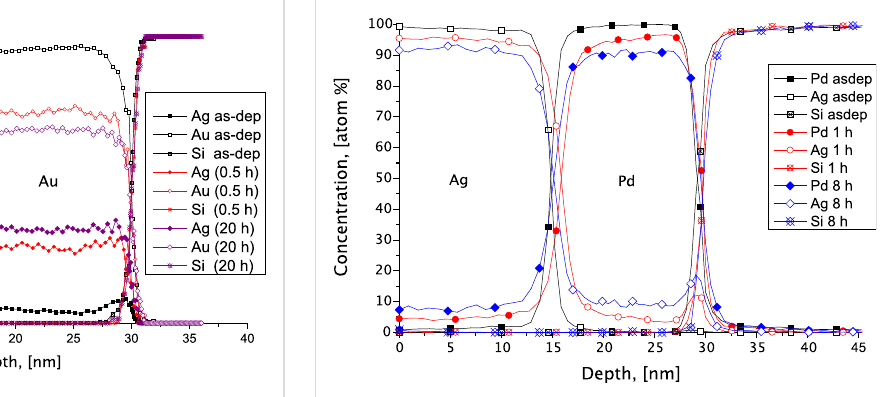
Figure 3: Concentration–depth profile of a Ag(15 nm)/Pd(15 nm) bilay- er; as deposited and annealed at 150